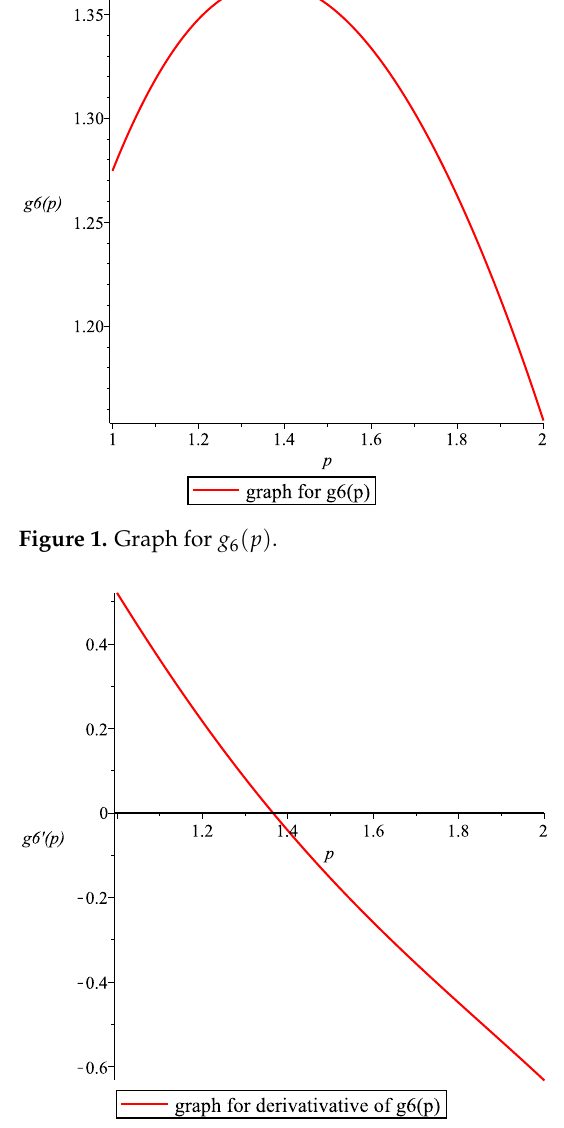
Figure 2. Graph for derivative of g 6 ( p )